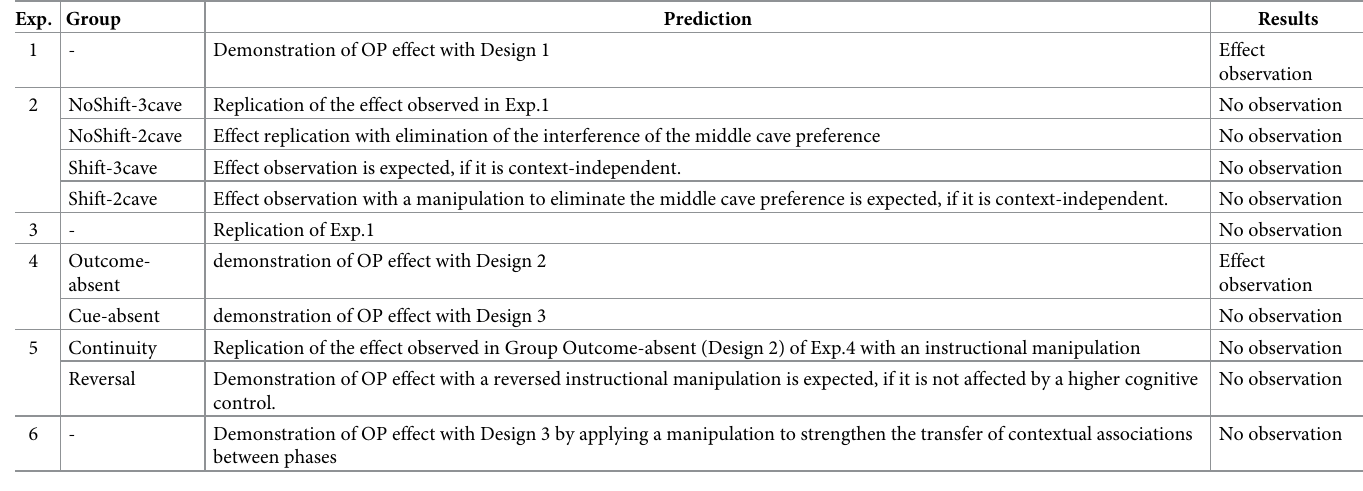
Table 3. Summary of predictions and results. Exp. Group